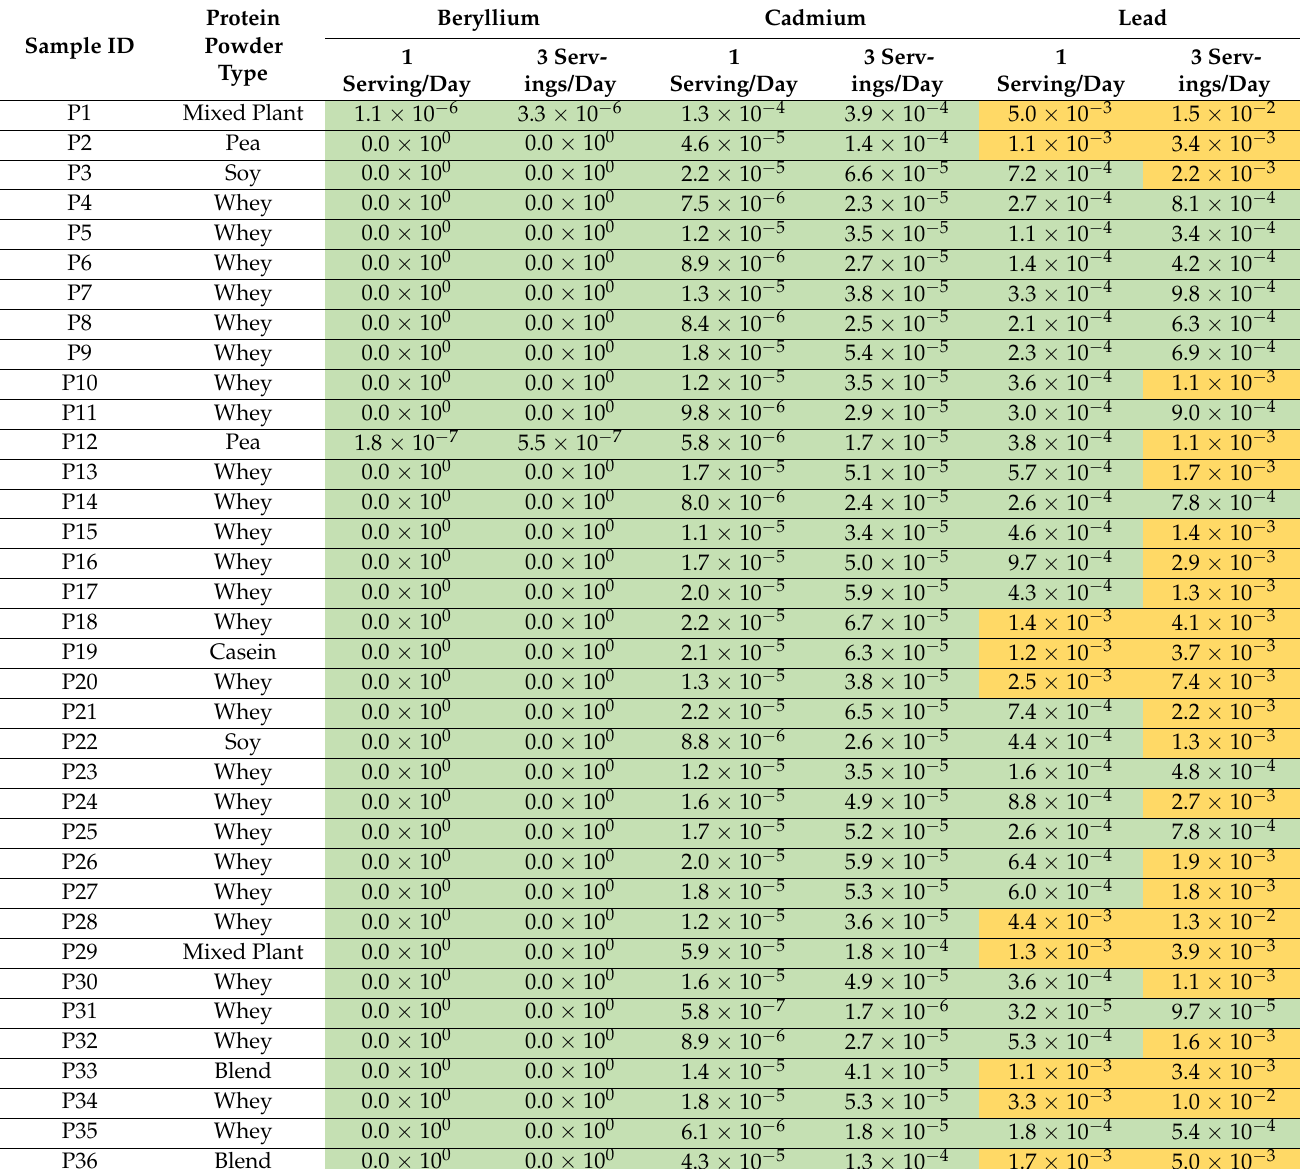
Table 8. Calculated cancer risk (CR) values for known and probable carcinogenic elements detected in protein powder samples (potential exposure for a 70 kg person).